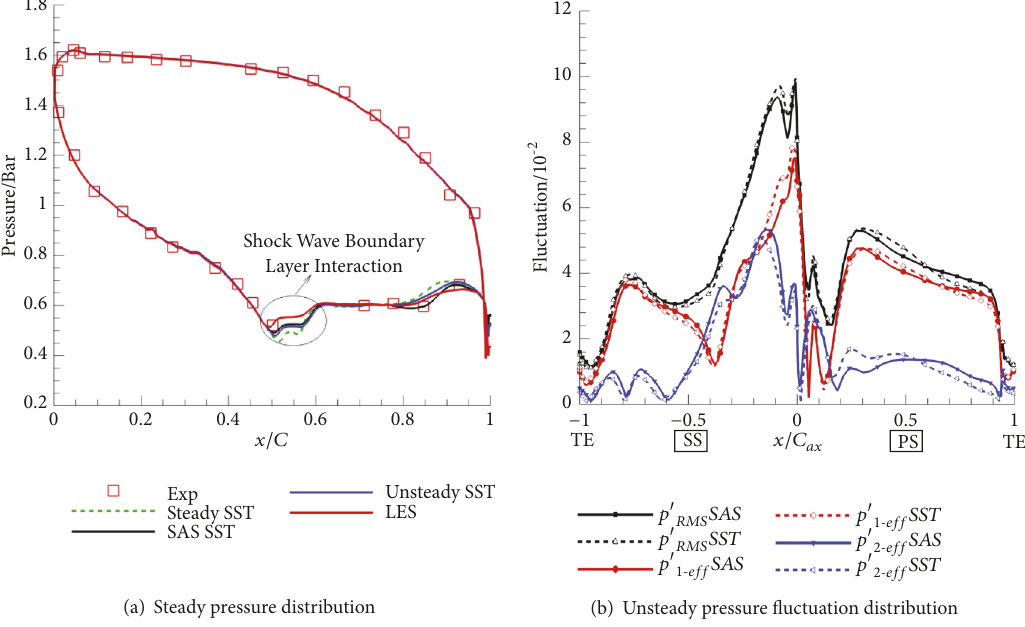
Figure 5: Validation of numerical